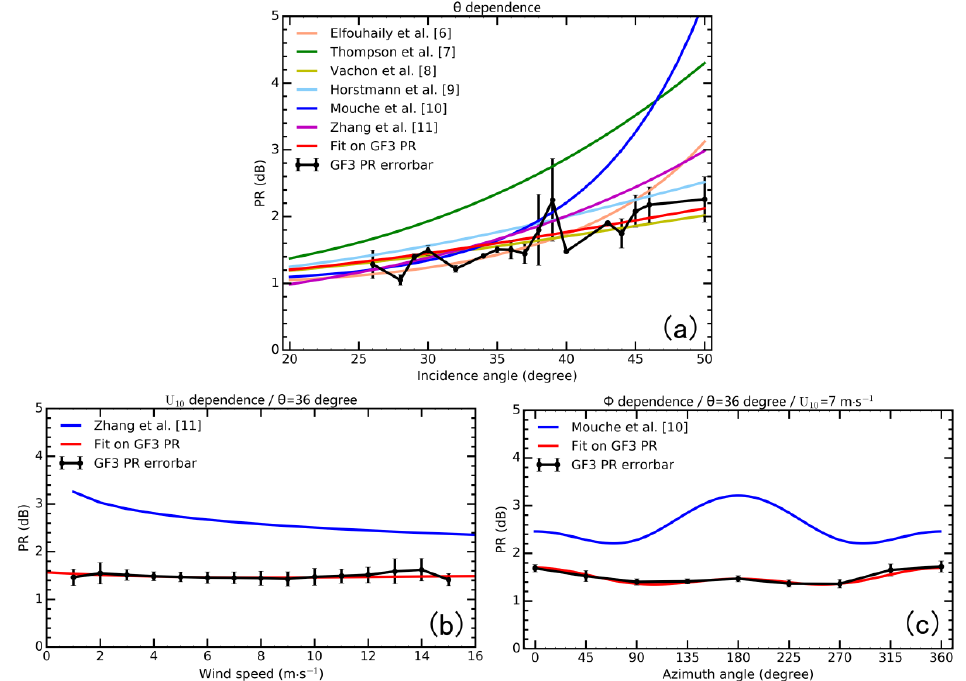
Figure 15. The GF-3 polarization ratio as a function of ( a ) incidence angle, ( b ) wind speed, and ( c ) azimuth angle. The GF-3 polarization ratios are fitted and compared to some proposed